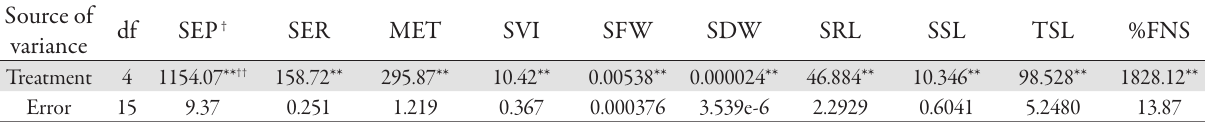
Tab. 1. Analysis of variance (mean of square) of seedling traits of R. turcomanicus Czerep, as affected by different seed harvesting